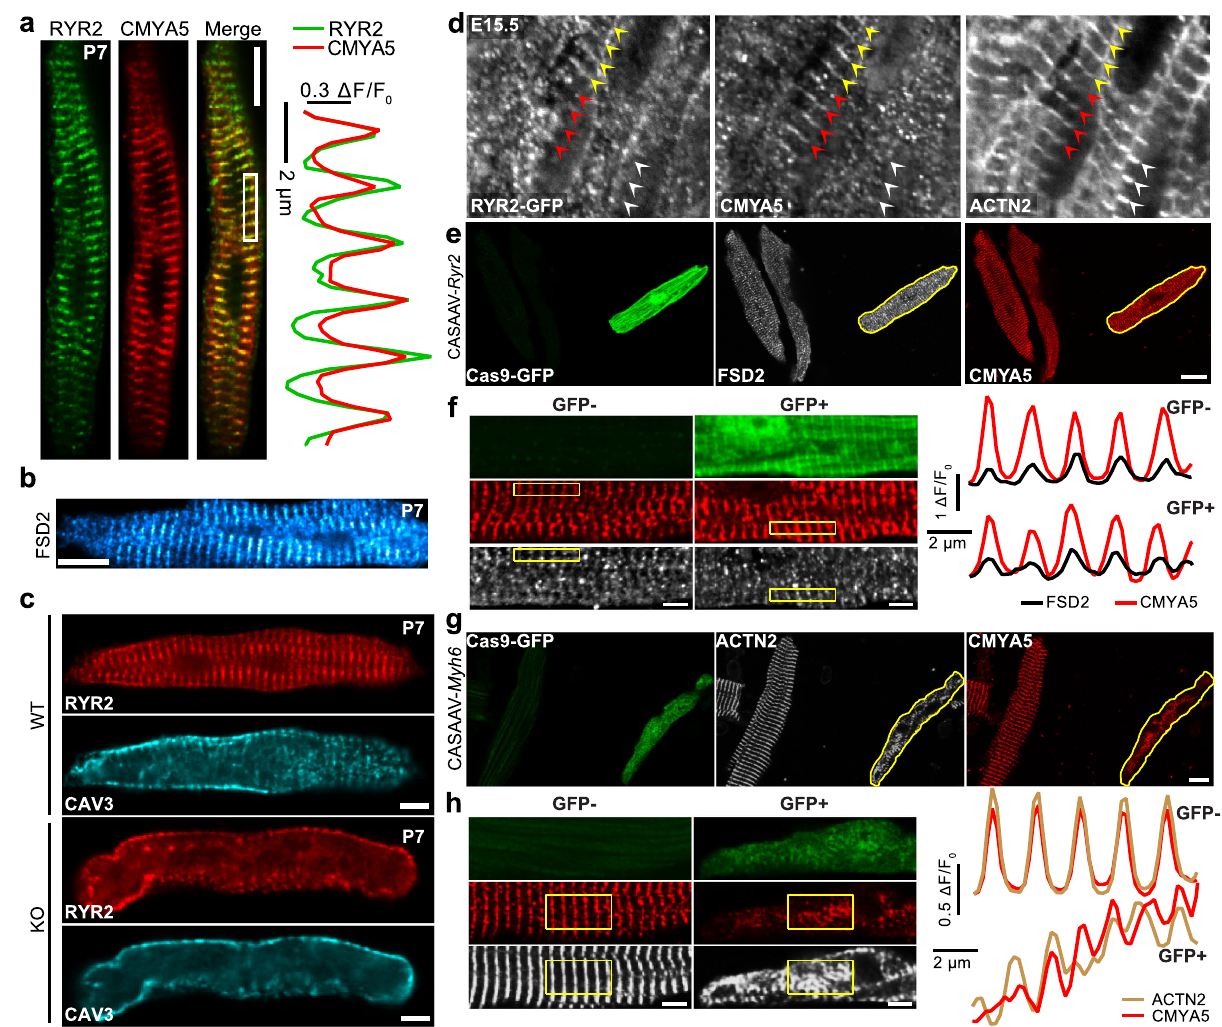
Fig. 3 CMYA5 positions jSR adjacent to Z-lines. a P7 ventricular cardiomyocyte co-immunostained for CMYA5 and RYR2. Bar, 10 µ m. Bottom, spatial pro fi le plot demonstrates co-localization of CMYA5 and RYR2 in a striated pattern. b Localization of FSD2 in P7 ventricular cardiomyocytes. FSD2 adopted a striated pattern. Bar, 10 µ m. Representative of two independent experiments. c jSR (RYR2) and T-tubule (CAV3) organization in WT and KO P7 ventricular cardiomyocytes. CMYA5 ablation caused loss of jSR organization. At this stage, T-tubules were not yet present in either genotype. Bar, 10 µ m. Representative of three independent experiments. d RYR2, CMYA5, and ACTN2 localization in WT E15.5 ventricular myocardium. Assembling sarcomere Z-lines (ACTN2) co-localized with CMYA5 alone (red arrowheads), CMYA5 and RYR2 (yellow arrowheads), or neither (white arrowheads). Bar, 5 µ m. Representative of fi ve independent experiments. e , f Effect of CASAVV-mediated ablation of RYR2 on CMYA5 and FSD2 localization. CASAAV somatic mutagenesis was used to deplete RYR2 in a subset of cardiomyocytes. CMYA5 and FSD2 localization was evaluated in RYR2-de fi cient (GFP + ) and control (GFP − ) cardiomyocytes. Spatial pro fi les of boxed areas in f , plotted at right, demonstrate that RYR2 ablation did not impact CMYA5 or FSD2 localization. Bar = 10 µ m ( e ), 5 µ m ( f ). Representative of three independent experiments. g , h Effect of CASAAV-mediated ablation of MYH6 on CMYA5 and ACTN2 localization. CASAAV was used to deplete MYH6 in a subset of cardiomyocytes. MYH6-de fi cient (GFP + ) had impaired sarcomerogenesis and disorganization of Z-line marker ACTN2, and CMYA5 organization was correspondingly deranged. Signal intensities in boxed areas in h are plotted to the right. Bar = 10 µ m ( g ), 5 µ m ( h ). Representative of three independent but not in Cmya5 KO (Supplementary Fig. 7). Neither (Supplementary Fig. 7a) or heart systolic function (Supplemen- tary Fig. 7b), suggesting that portions of CMYA5 within the N-terminal portion of the protein contribute to CMYA5 localization. With the exception of amino acids 78-319, CMYA5 ’ s N-terminus is poorly conserved 34 . When expressed in cardio- myocytes in vivo, CMYA5[1-450] and CMYA5[1-1200], which share the conserved region, co-localized well with Z-line marker ACTN2 (Supplementary Fig. 7c). These data indicate that the N-terminal portion of CMYA5 likely promotes its localization at Z-lines and its role in maintaining heart function.